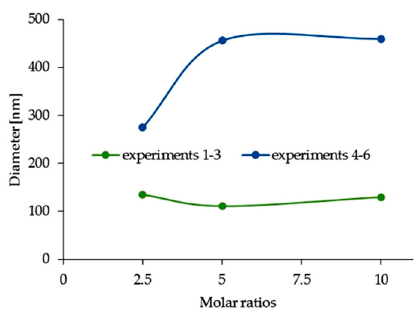
Figure 7. Size of silver nanoparticles capped with 16-O-16 and 16-6-16 as a function of nAg/nGem- ini molar ratio.